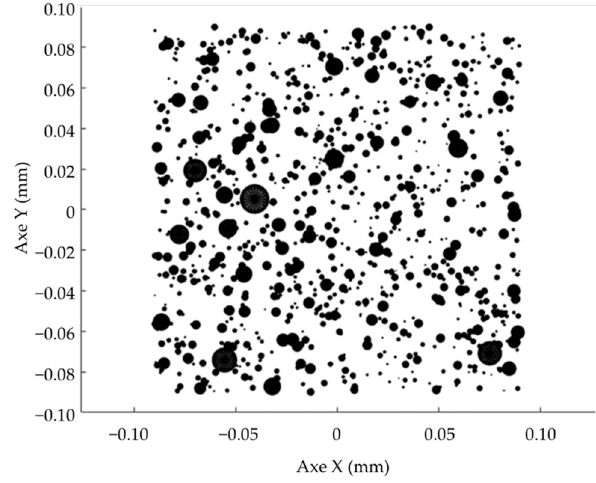
Figure 5. Enhancement of spherical particle distribution on a 100 × 100 µ m square in the simu- lated filter.